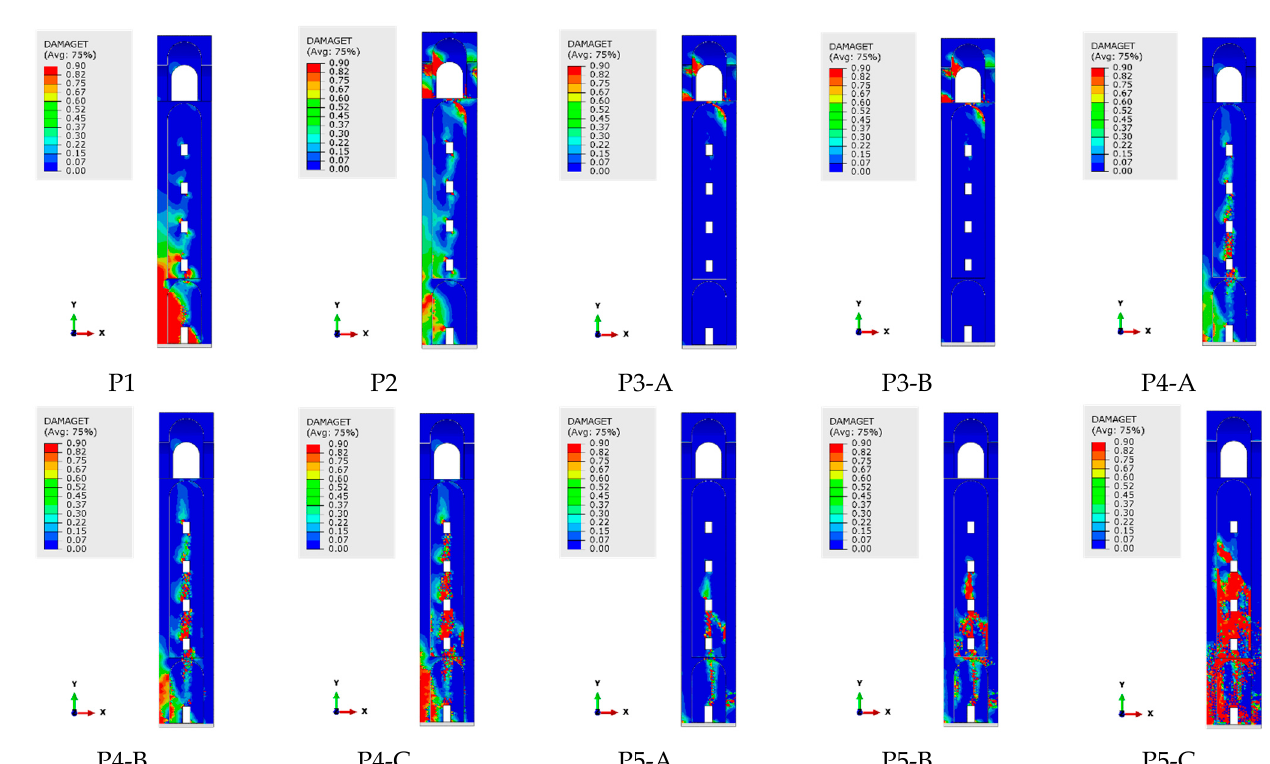
Figure B4. Pushover analyses results of T2-M1—Damage patterns.